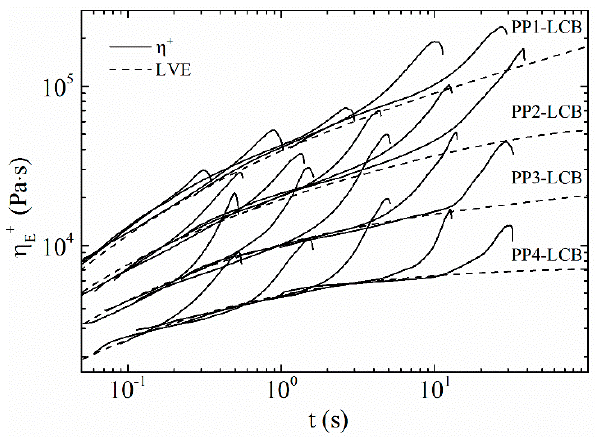
Figure 12. Extensional rheology of the LCB-PPs.